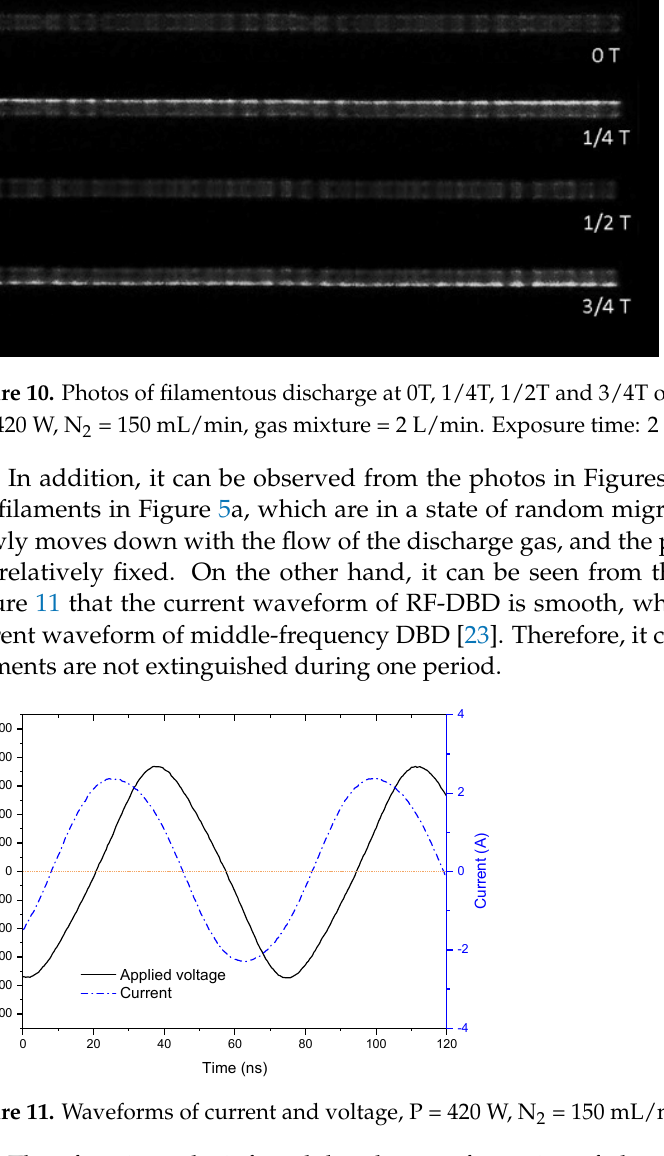
Figure 11. Waveforms of current and voltage, P = 420 W, N 2 = 150 mL/min, gas mixture = 2 L/min. Therefore, it can be inferred that the transformation of glow discharge to filamentous discharge in double dielectric discharge using argon-doped nitrogen is due to the fact that when the voltage reaches a certain value, ions gain enough speed to destroy the plasma sheath, and charge accumulation is formed on the cathode surface, thus forming filamentous